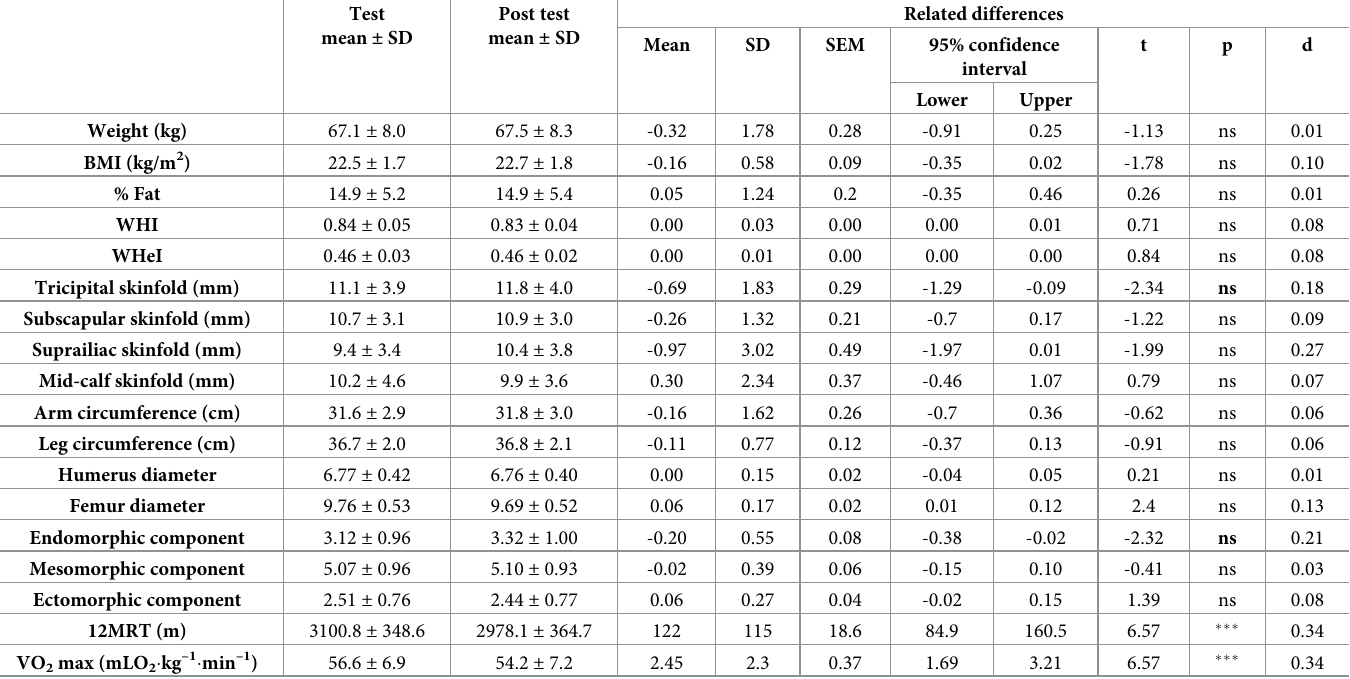
Table 2. Mean values and SD before and after 12 weeks without mandatory physical training (n =